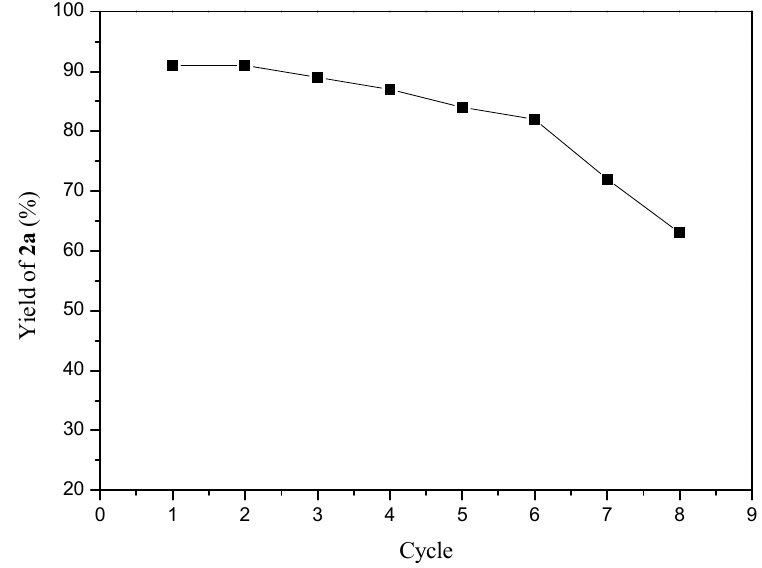
Figure 2. The reusability of Novozym 435 on the oxidation of salicyl alcohol. Reaction conditions: 1a (1 mmol), acetonitrile (5 mL), UHP (1.1 mmol), n -Caprylic acid (0.2 mmol), TEMPO (0.05 mmol), Novozym 435 (200 U), room temperature, 2 h; isolated yield.